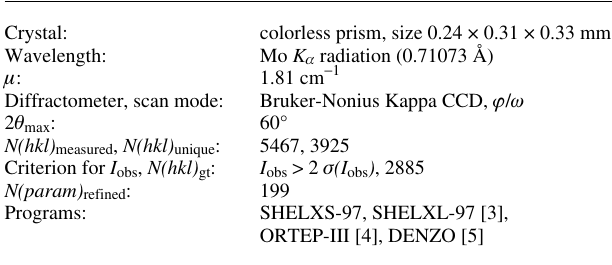
Table 1. Data collection and